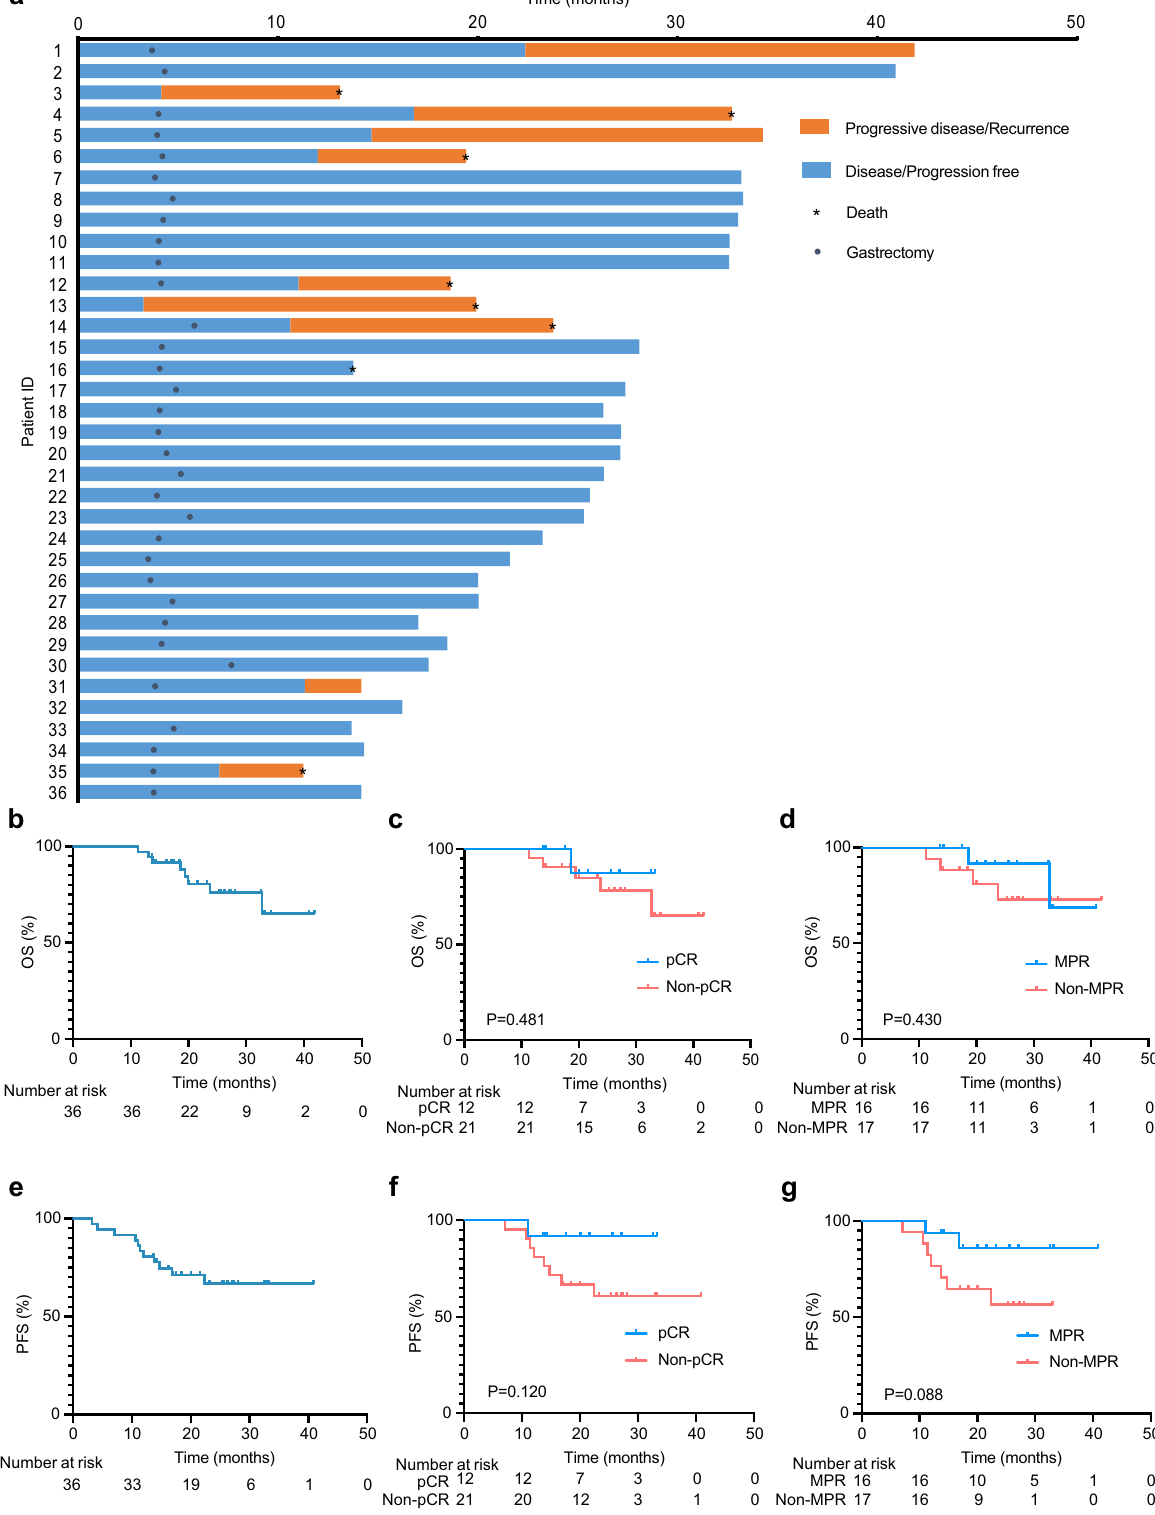
analysisset. f Kaplan – Meier curvesforprogression-free survival inpatients with or without pCR. A two-sided log-rank test was used to determine the statistical sig- ni fi cance between subgroups. g Kaplan – Meier curves for progression-free survival in patients with or without MPR. A two-sided log-rank test was used to determine the statistical signi fi cance between subgroups. pCR pathological complete response, MPR major pathological response. Source data are provided asa Source Data fi